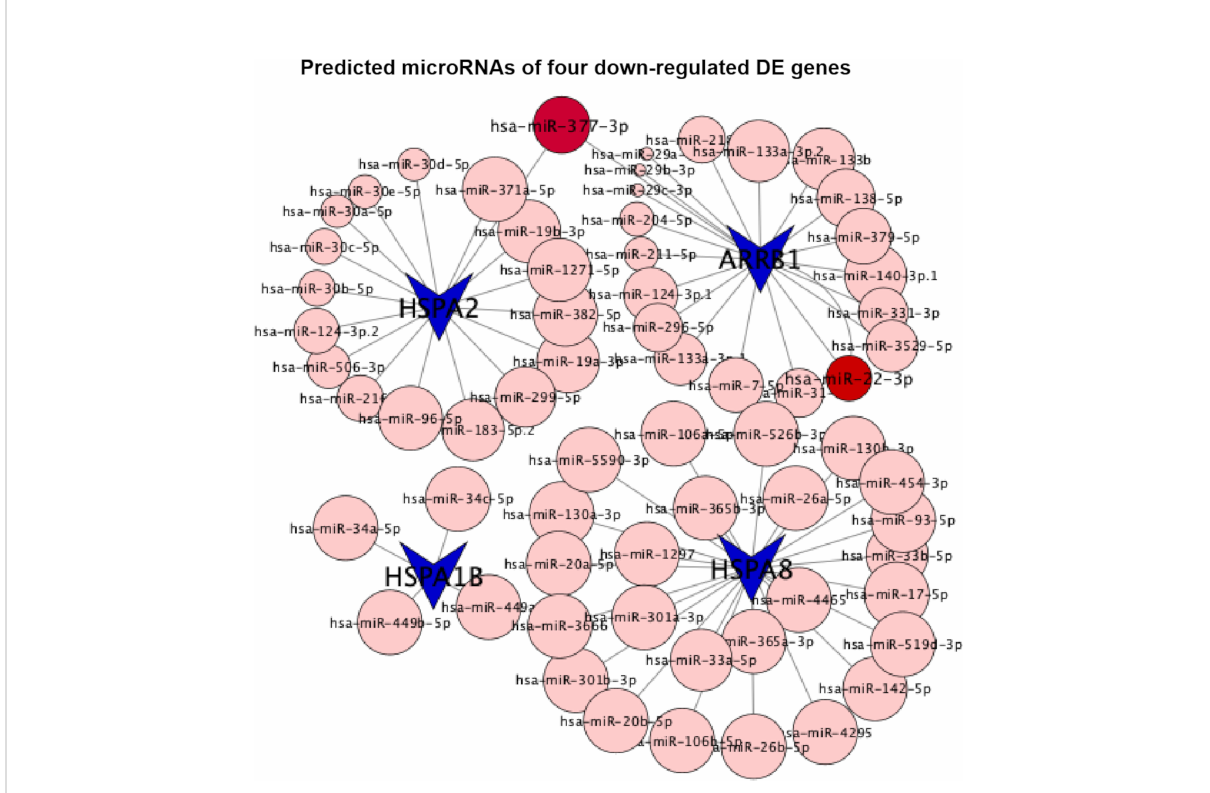
FIGURE 8 Predicted microRNAs (conserved sites) of four extremely downregulated differentially expressed (DE) genes (H SPA8 , HSPA2 , HSPA1B , and ARRB1 ). The circles indicate the context++score percentiles of the predicted microRNAs, where hsa-miR-377-3p is visualized with the score equal to 87 predicted by HSPA2